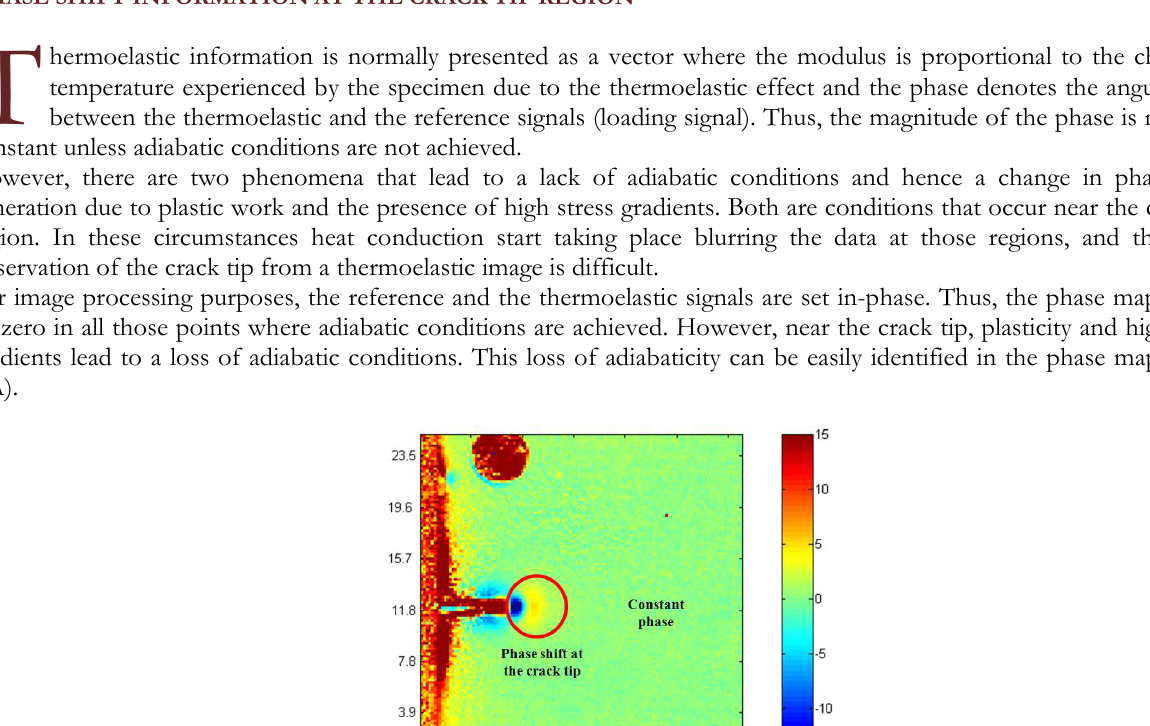
P HASE SHIFT INFORMATION AT THE CRACK TIP REGION